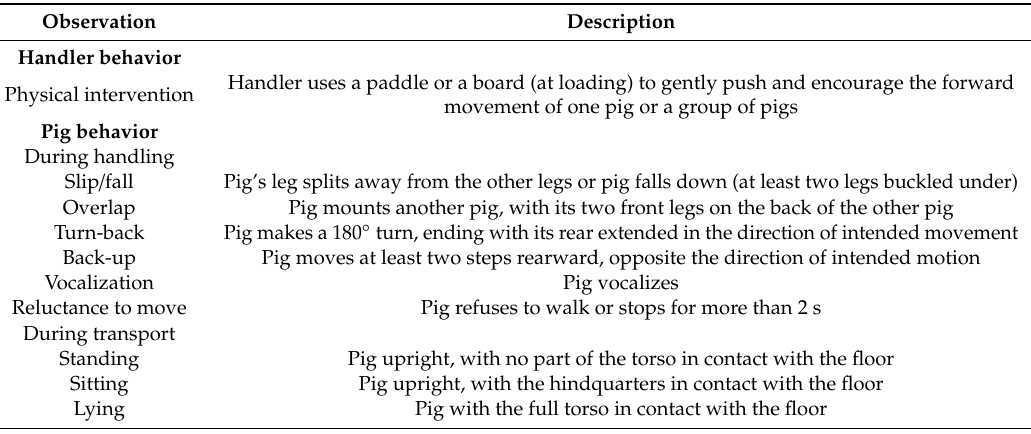
Table 1. Ethogram of handler behavior toward pigs and pig behavior during loading and transport (adapted from References